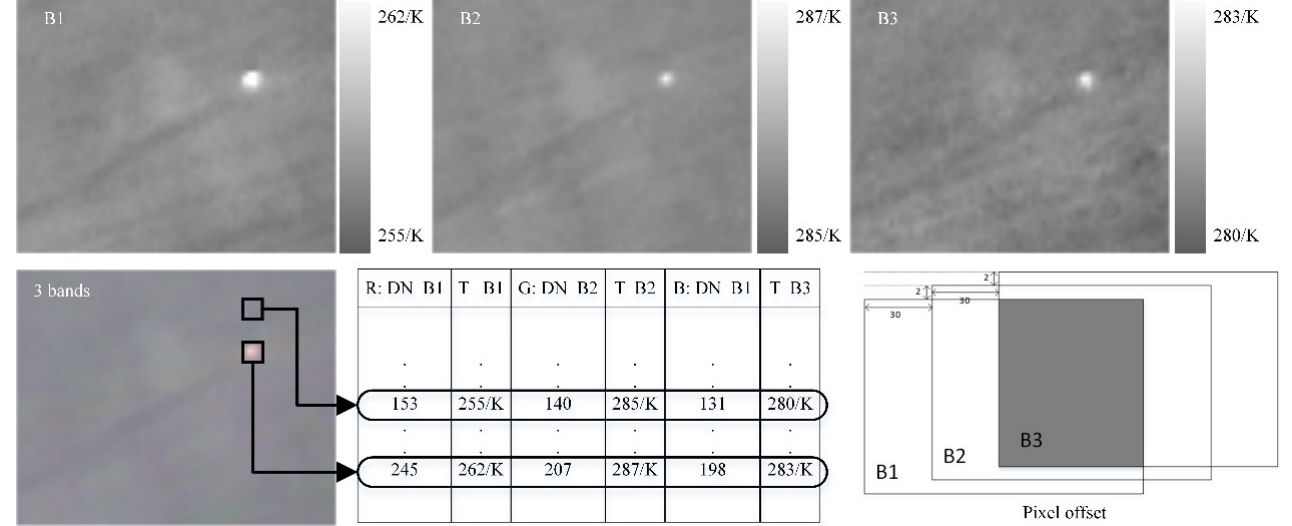
Figure 2. The intensity images of B1: 11.5~12.5 µm, B2: 8~10.5 µm, B3: 10.3~11.3 µm. The brightness temperature on the pupil (T/K) are marked in the color bar, and the three-bands pseudo-color image with the resolution of 30 m in Yellow Sea of China from SDGSAT-1 TIS is shown in the bottom left. The digital number (DN) of the ship and sea surface and the brightness temperature on the pupil (T/K) of the ship and sea surface are shown in the table on the right. The horizontal pixels offset of B1–B2 and B2–B3 is thirty pixels, and the vertical pixels offset of B1–B2 and B2–B3 is two pixels, as shown on the bottom right.